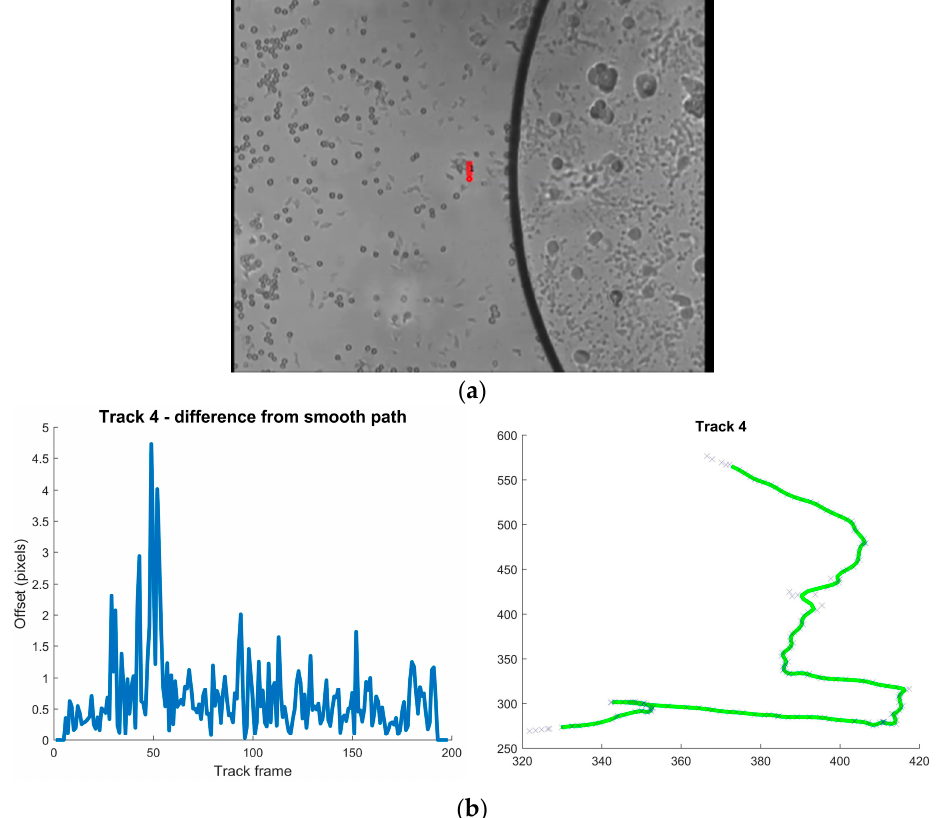
Figure 2. (Video S2) ( a ) Miracidia released from isolated Schistosoma mansoni eggs suspended in water swim in droplet on microscope slide under a coverslip. Digitized VHS-video recording as described in the text of Figure 1. Eleven miracidia were identified by computer vision and trajectories of 7 were analyzed in detail (video recording with trajectories). ( b ) The almost linear trajectories of miracidia in water are interrupted as an obstacle is encountered. The graph to the left shows deviations from a straight path and abrupt turnabouts upon contact with an obstacle (an air bubble). The curve to the right (labeled Track 4) shows the rolling average smoothed path in green and measurements corresponding to track 4 seen in Figure 2a.